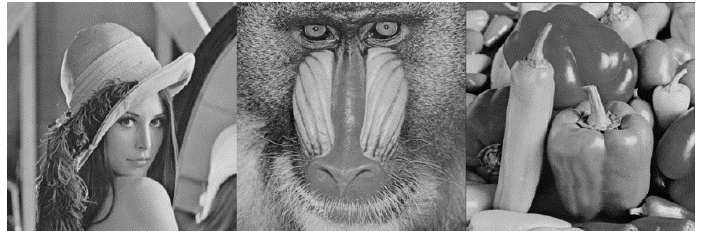
Figure 10. Three images (from left to right: Lena, Baboon, and Pepper) used for comparison between the SR-SYBA and the original SYBA algorithms.